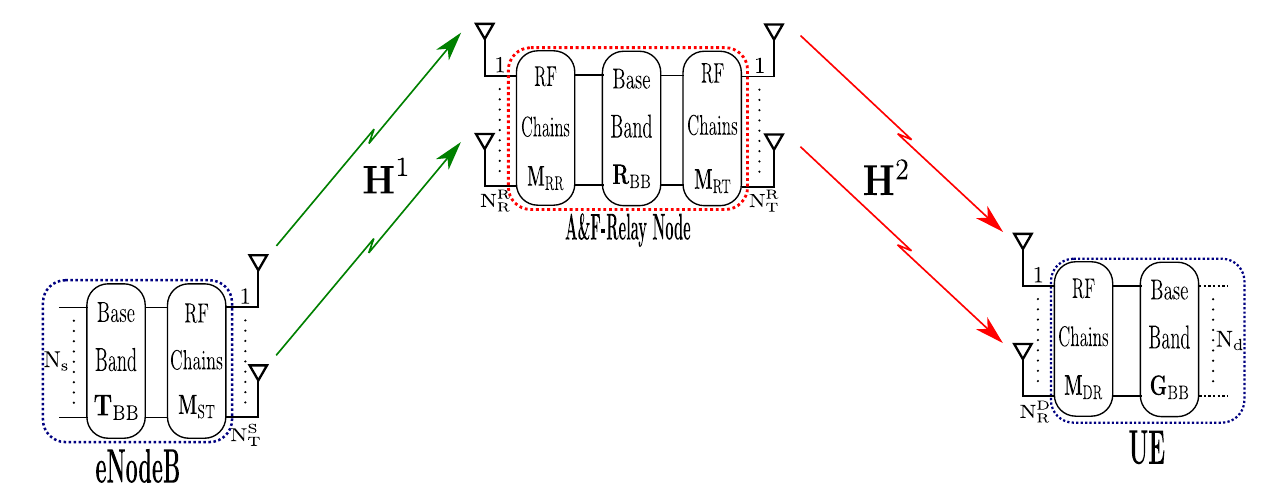
Figure 2. Two-hop A&F MIMO Relay Node Co-operative